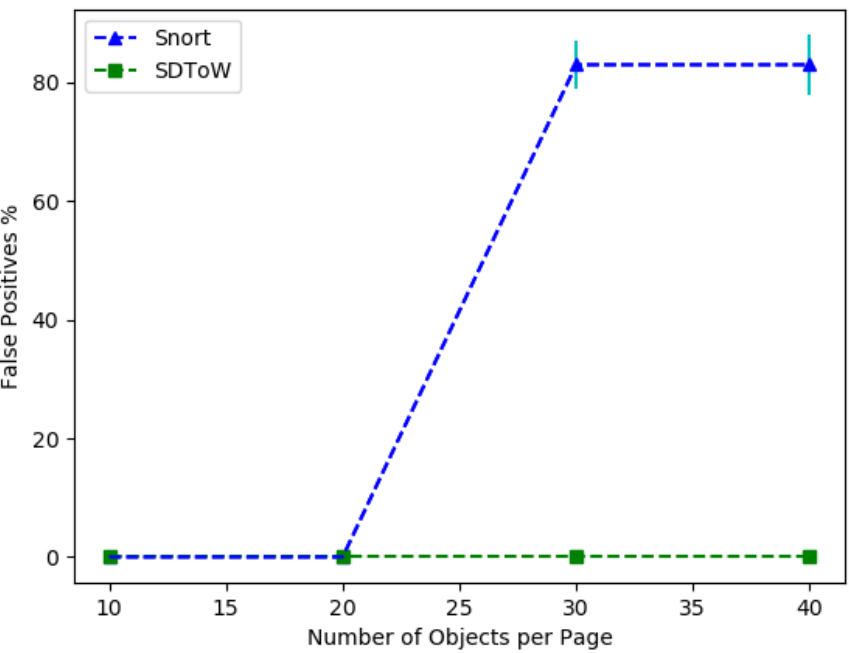
Figure 13. False positive errors comparison between Snort and